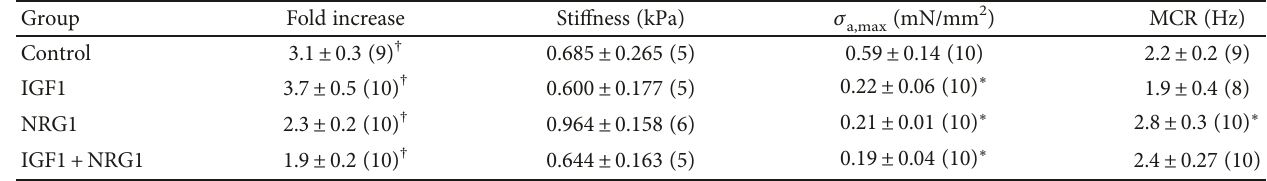
Table 1: Contractile and mechanical characteristics of engineered